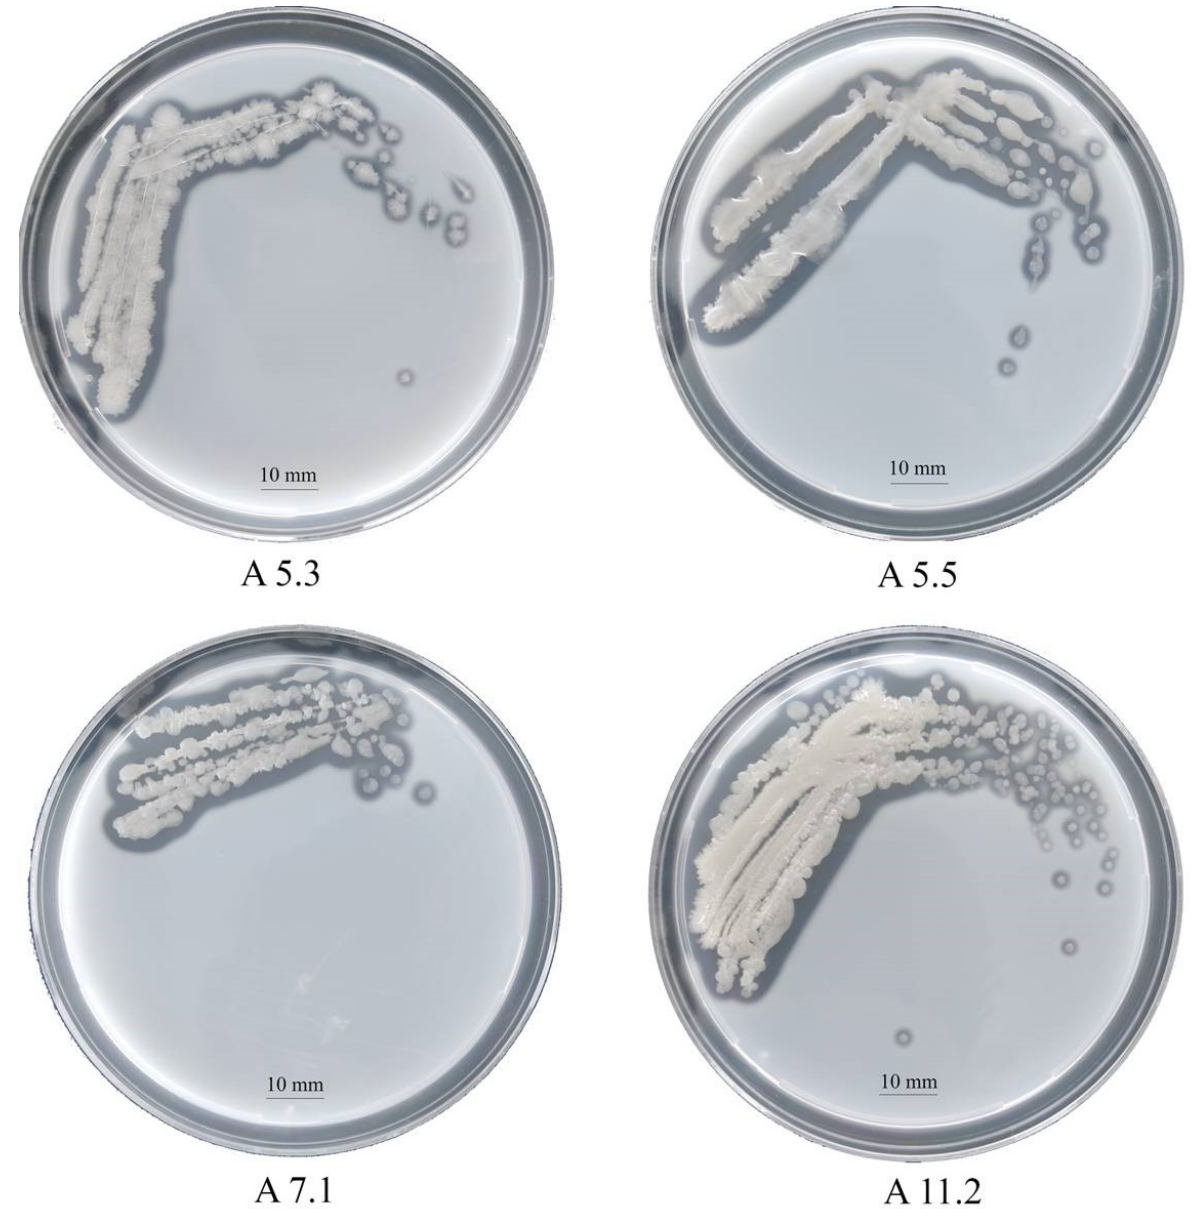
Figure 1. Colonies of Bacillus isolates A5.3, A5.5, A7.1, and A11.2 on a skim milk agar plate. Cultivation of the isolates on the feather medium for 96 h showed that Bacillus sp. A5.3 possesses the highest activity (Figure 2).